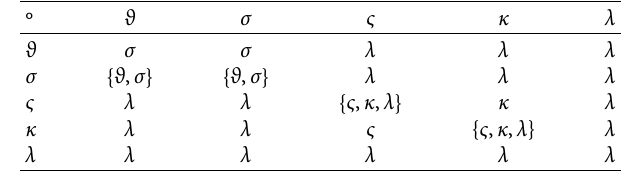
Table 3: Hyperoperation “ ° ”defned on Θ � ϑ , σ , ς , κ , λ { } .